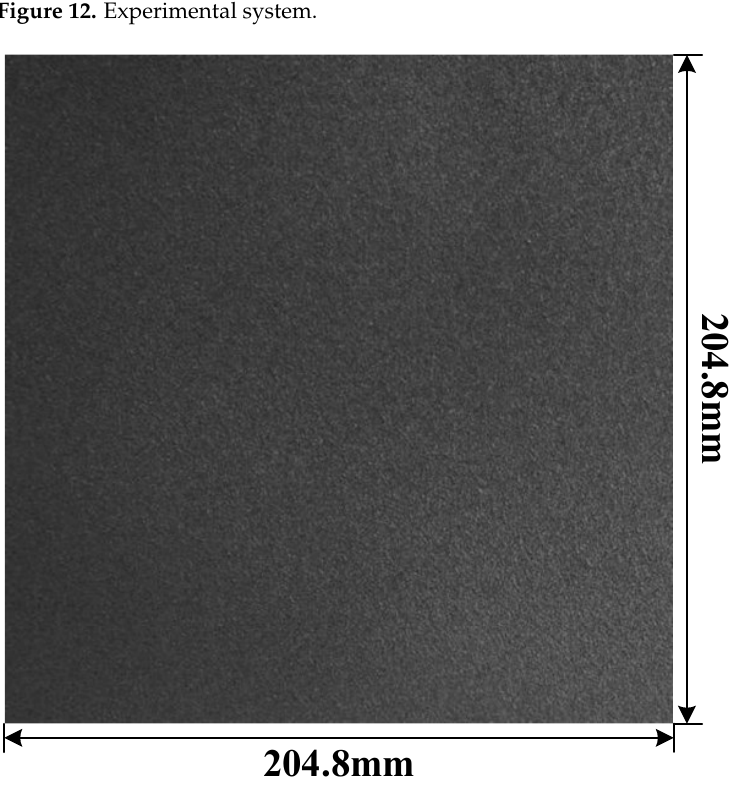
Figure 13. Real speckle